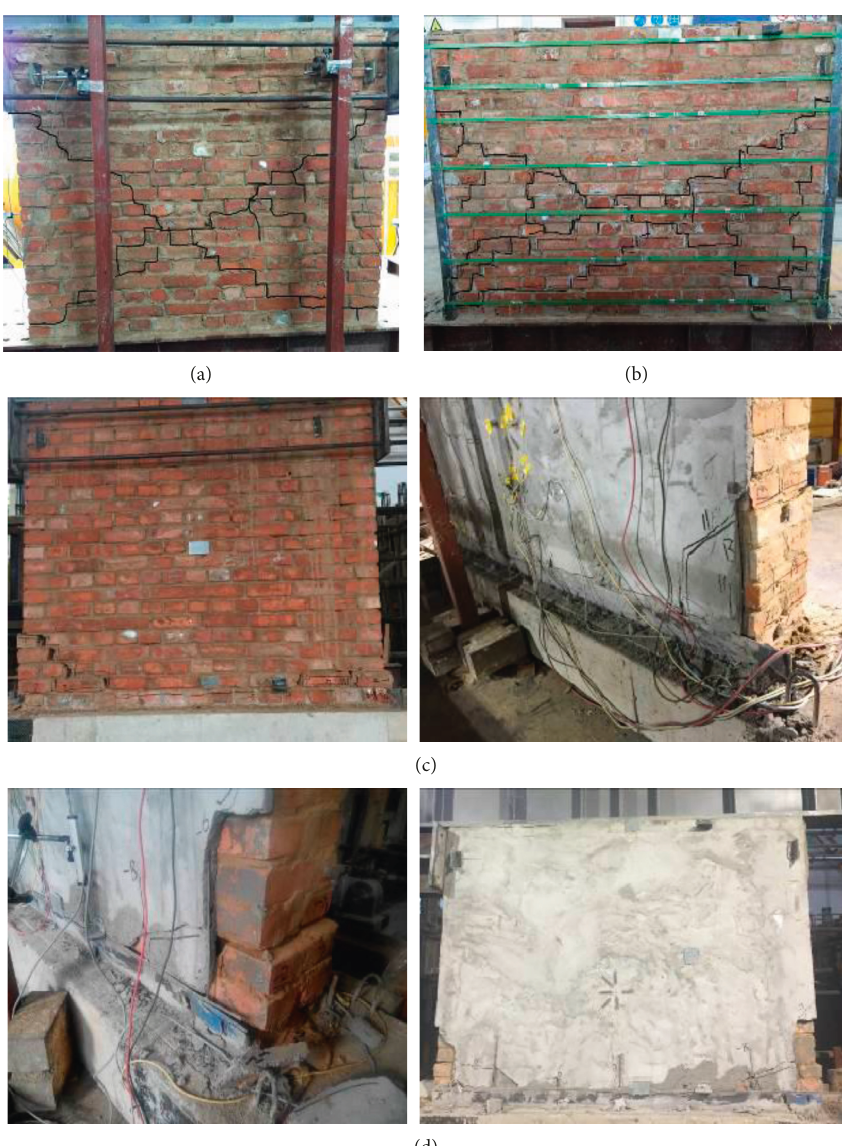
Figure 3: Failure modes of specimens: (a) specimen #1; (b) specimen #2; (c) specimen #3; (d) specimen